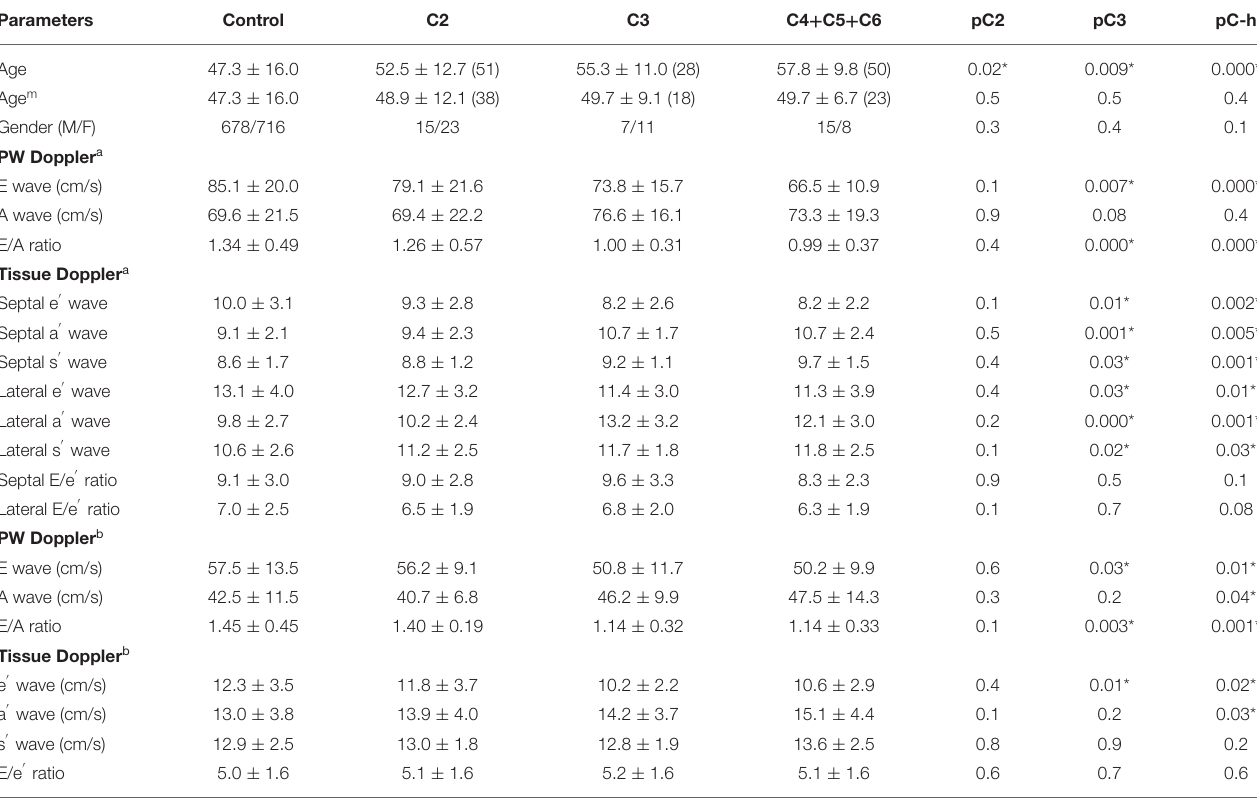
TABLE 5 | Difference statistical analysis in cardiac Doppler parameters between different CEAP clinical class age-matched patients and normal control.